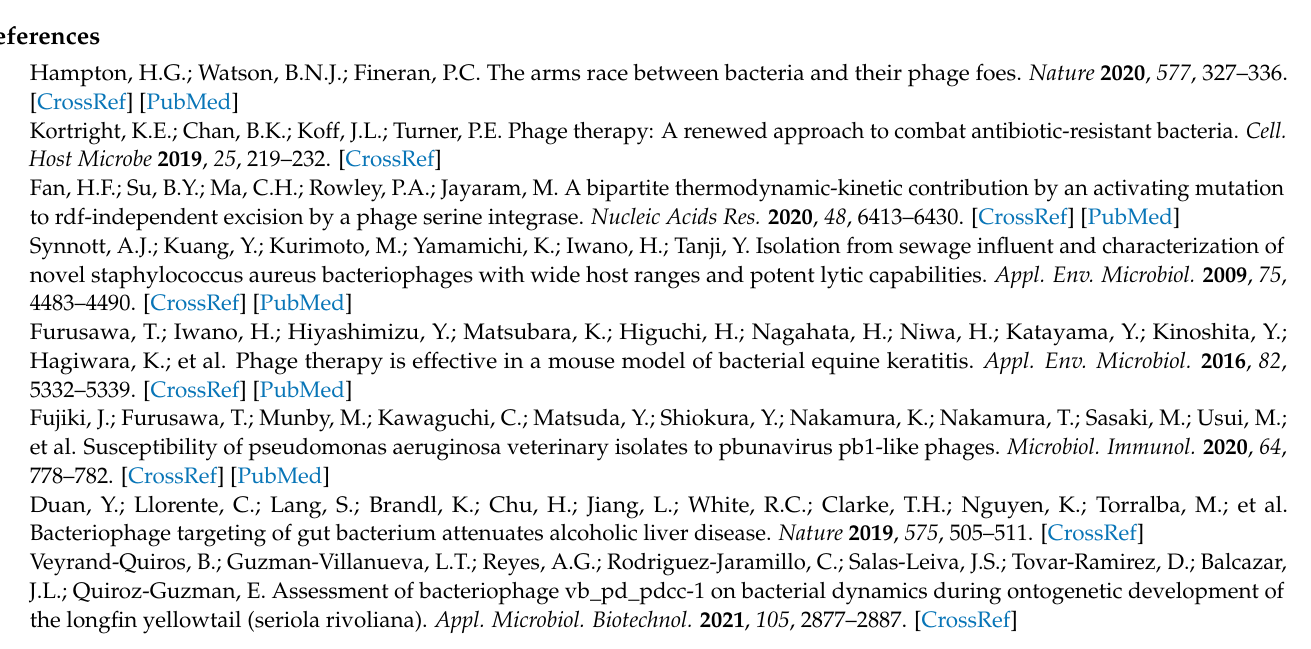
Table S1: Products and predicted functions of proteins encoded by each region described in Figure